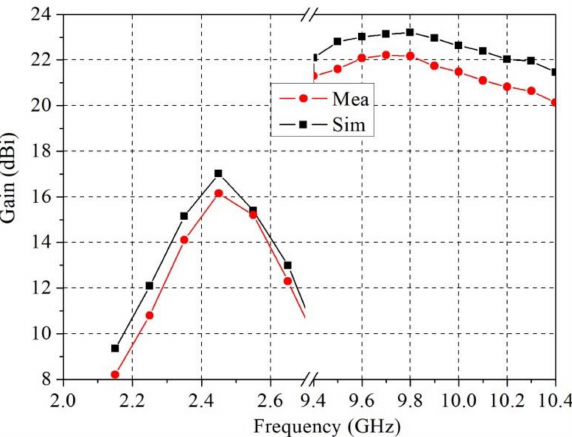
Figure 11. Simulated and measured gains of the proposed antenna at around 2.45 and 10